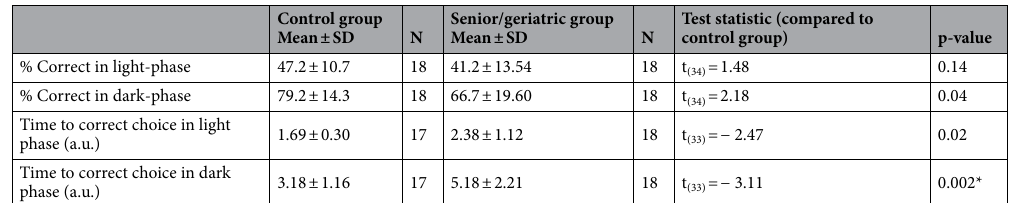
Control group Mean ± SD